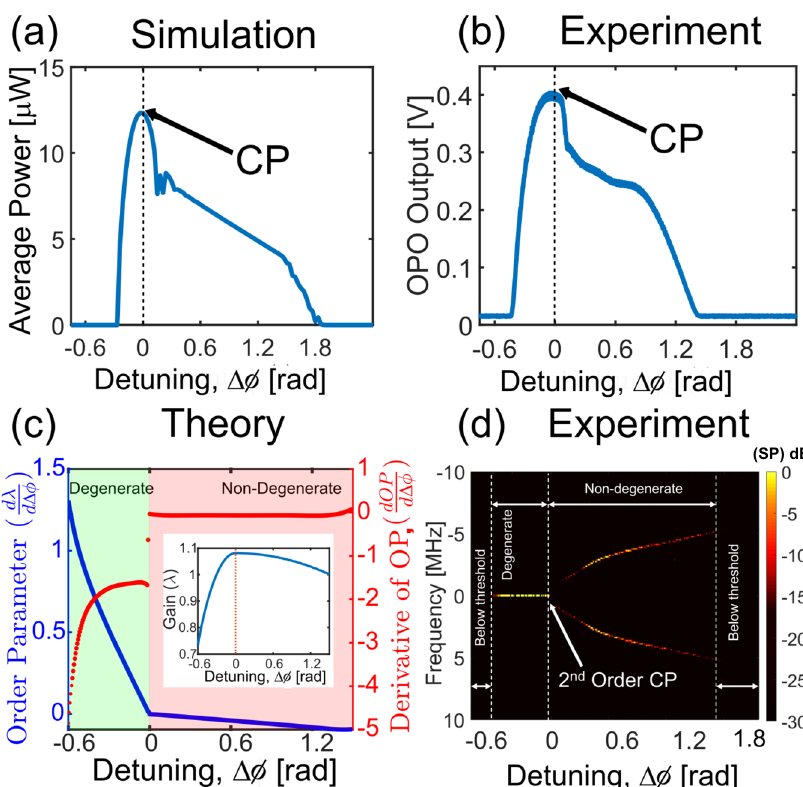
Fig. 3 Characterization of the second-order critical point. OPO average output power as a function of cavity detuning obtained numerically ( a ) and experimentally ( b ) using a slow detector. This demonstrates the maximum conversion ef fi ciency at the critical point. c Continuous order parameter but discontinuous derivative typical of a second-order phase transition. The inset shows the gain curve as a function of cavity detuning, which has its maximum at the critical point. d Spontaneous emergence of beat-note around the critical point. Measured RF spectrum (SP) captured using a fast detector in a multi- heterodyne measurement showing co-existence of the signal and idler combs in the non-degenerate regime and their offset